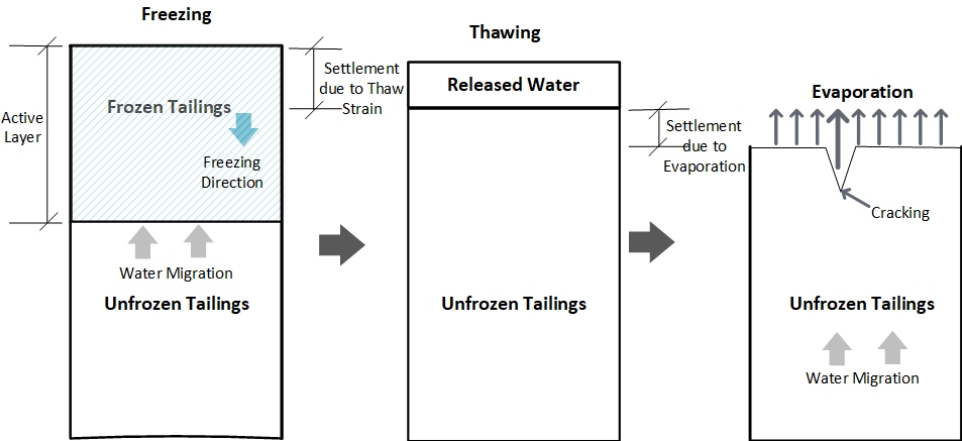
Figure 1. Simplified diagram of the seasonal weathering cycles.